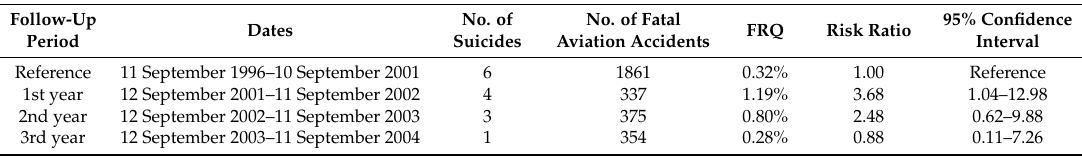
Table 1. The number and the risk ratios of pilot aircraft ‐ assisted suicides five years before and three years after 11 September 2001, in the U.S.